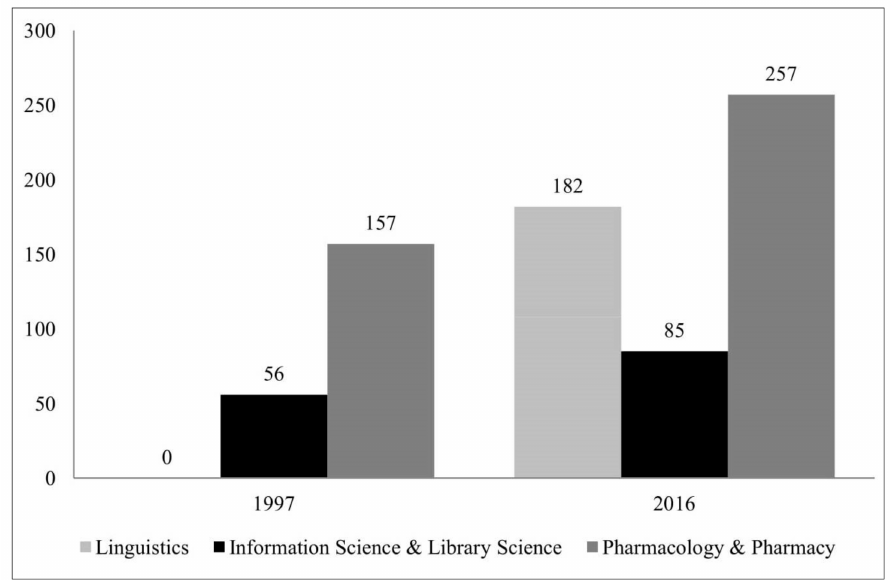
Figure 2. Web of Science (WoS) indexed journals in 1997 and 2016 (by category in both